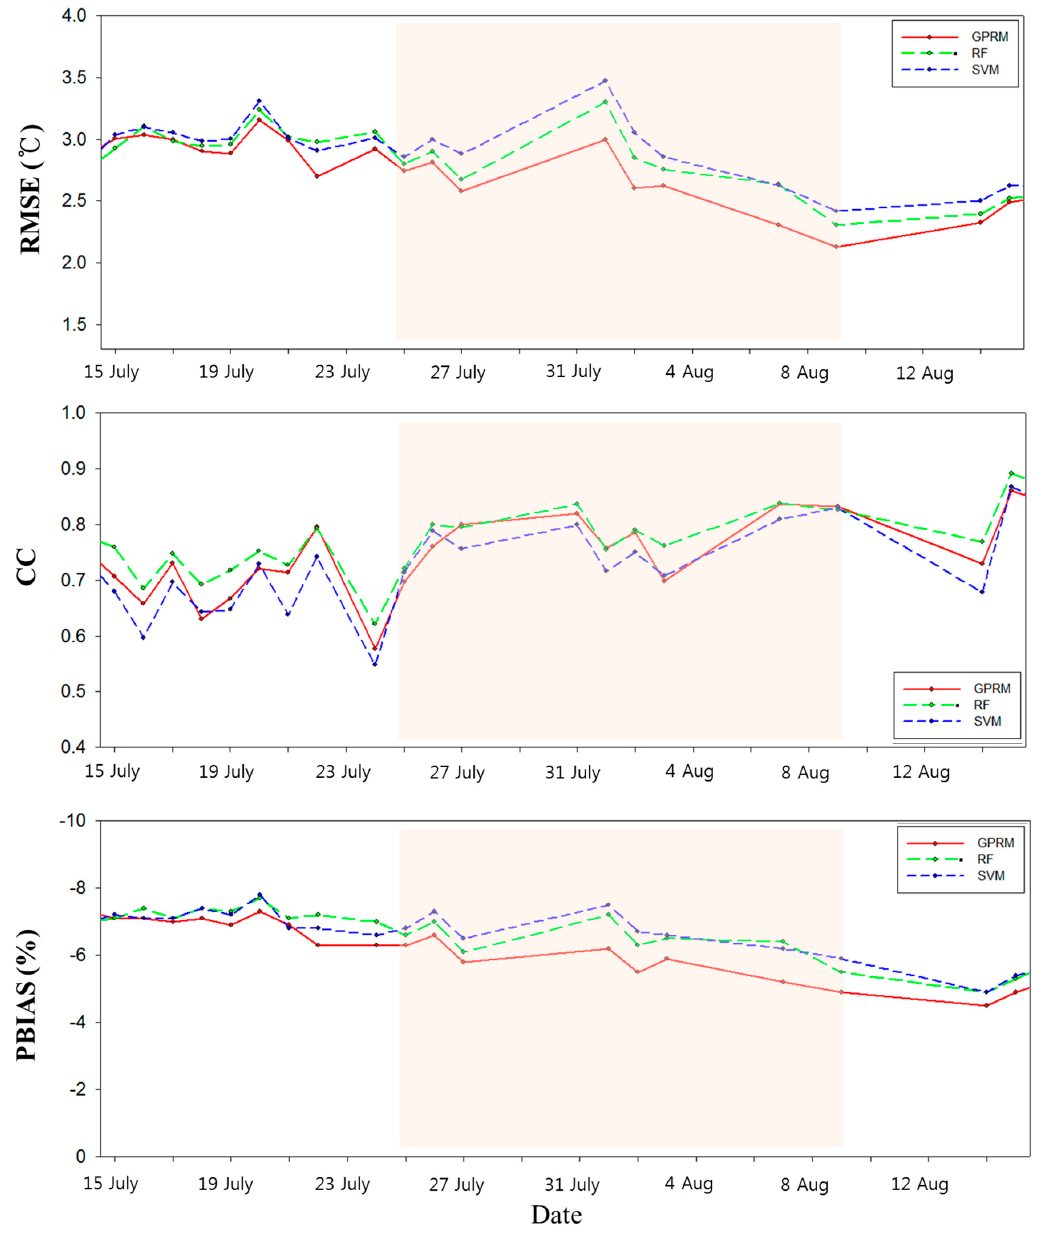
Figure 8. Verification results of daily maximum temperature prediction data with a 1 km resolution using observation data for the urban areas. The bright orange shading is the hottest time of summer in